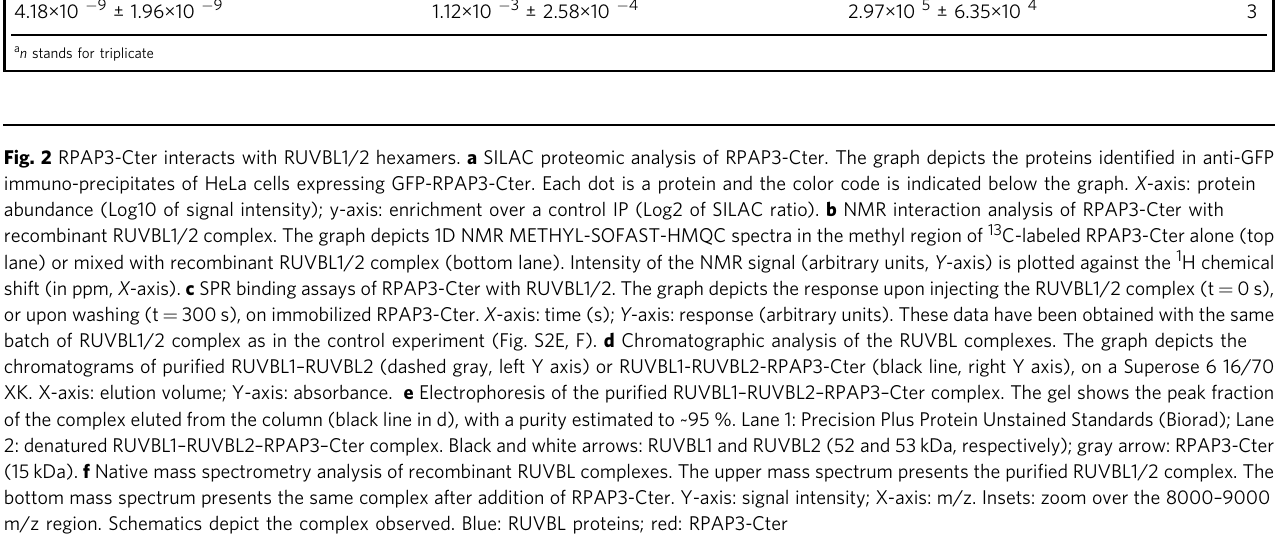
Table 2 RUVBL1/2:RPAP3 – Cter af fi nity and kinetic interaction parameters determined by SPR His_RUVBL1_Flag_RUVBL2 interaction with immobilized RPAP3-Cter K D